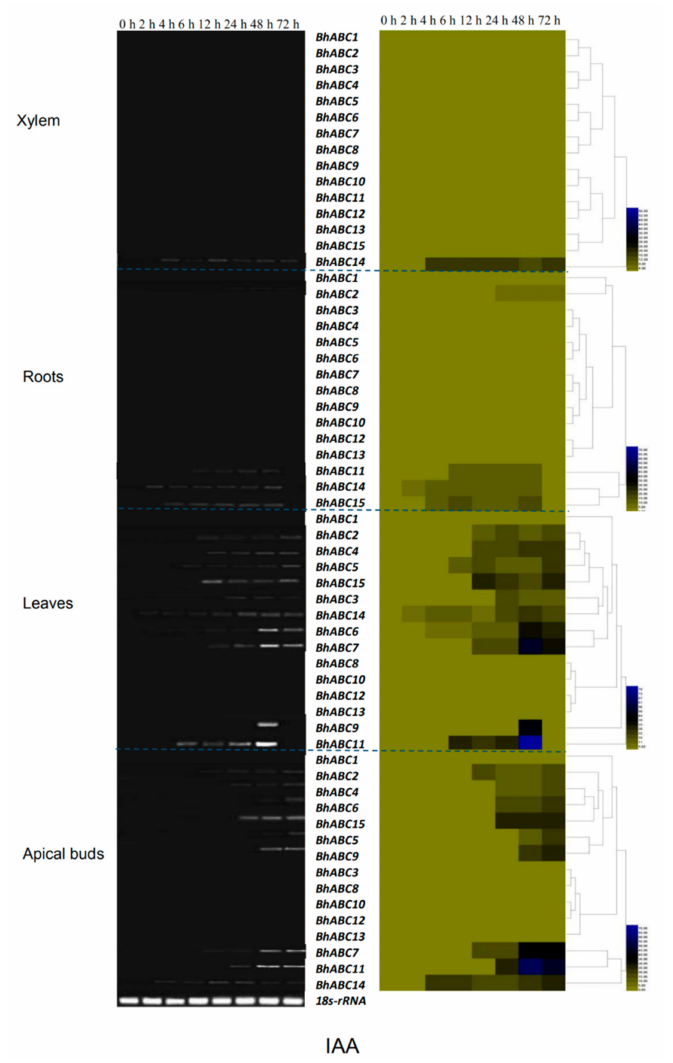
Figure 8. Expression patterns of BhABC genes in xylem, roots, leaves, and apical buds after IAA treatment. Heat map showing responses of BhABC genes to IAA (right); semi-quantitative RT-PCR analysis with 18s RNA internal reference